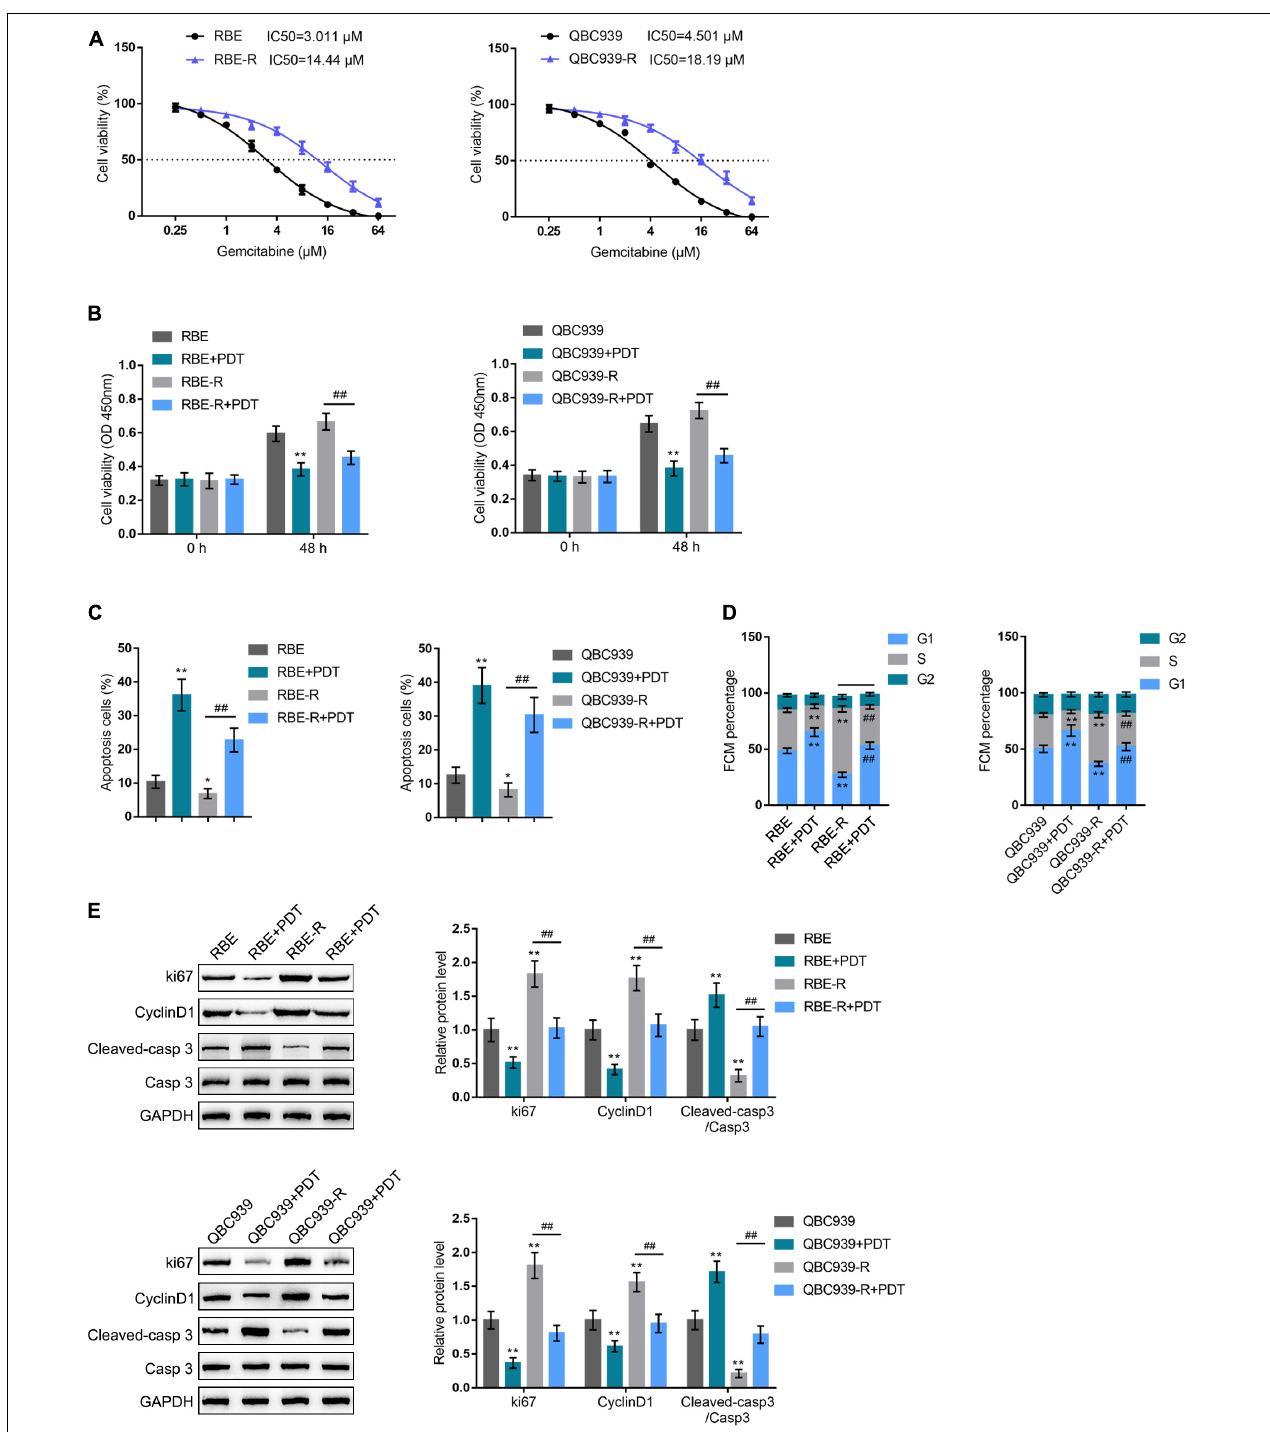
FIGURE 1 | Effects of PDT on gemcitabine-resistant cholangiocarcinoma cells. (A) Gemcitabine-resistant cholangiocarcinoma cell lines, RBE-R and QBC939-R were established as described; the cell viability was determined by MTT assays and shown as the IC50 values. (B) Regular and gemcitabine-resistant cholangiocarcinoma cell lines were exposed or non-exposed to PDT treatment and examined for the cell viability by MTT assays. Then, RBE, QBC939, RBE-R, and QBC939-R cells were exposed or non-exposed to PDT treatment and examined for the cell apoptosis by Flow cytometry (C) ; cell cycle distribution by Flow cytometry (D) ; the protein levels of ki67, Cyclin D1, cleaved-caspase 3, and caspase 3 by Immunoblotting (E) . * P < 0.05, ** P < 0.01, ## P < 0.01.